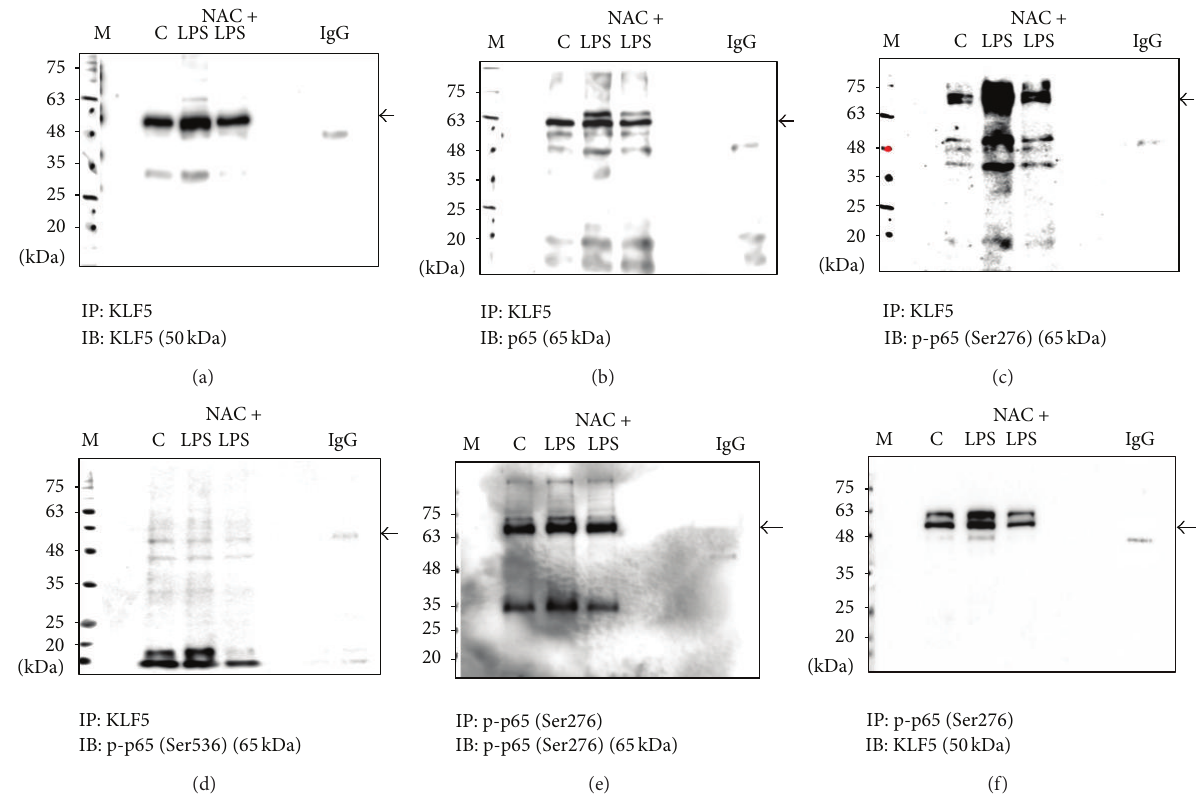
Figure 5: Kr¨uppel-like factor 5 (KLF5) interacts with nuclear factor-kappaB subunit in the nuclei of human bronchial epithelial cells. Cells from the HBEC line were treated with lipopolysaccharide (LPS; 5 𝜇 g/mL) for 1 h, with or without N-acetylcysteine (NAC) pretreatment (10mM). The nuclear protein extracts were immunoprecipitated with KLF5 or anti-immunoglobulin G (IgG) antibodies (Abs) and then analyzed using western blotting and Abs against (a) KLF5 (molecular weight [MW]: 50 kDa), (b) p65 (MW: 65 kDa), (c) phospho-p65 (Ser276; MW: 65 kDa), and (d) phospho-p65 (Ser536; MW: 65 kDa). Nuclear protein extracts were immunoprecipitated with Abs against phospho-p65 (Ser276) or anti-IgG and then analyzed using western blotting and Abs against (e) phospho-p65 (Ser276) and (f) KLF5 to confirm the interaction between KLF5 and phospho-p65 (Ser276). The target protein was marked along with a nonspecific binding site. LPS-induced KLF5 coprecipitates with KLF5 (a), p65 (b), and phospho-p65 (Ser276) (c) but not with phospho-p65 (Ser536) (d). The results of immunoprecipitation with a phospho-p65 (Ser276) Ab and immunoblotting for phospho-p65 (Ser276) (e) and KLF5 (f) showed that phospho-p65 (Ser276) interacted with KLF5 proteins in cells from the HBEC